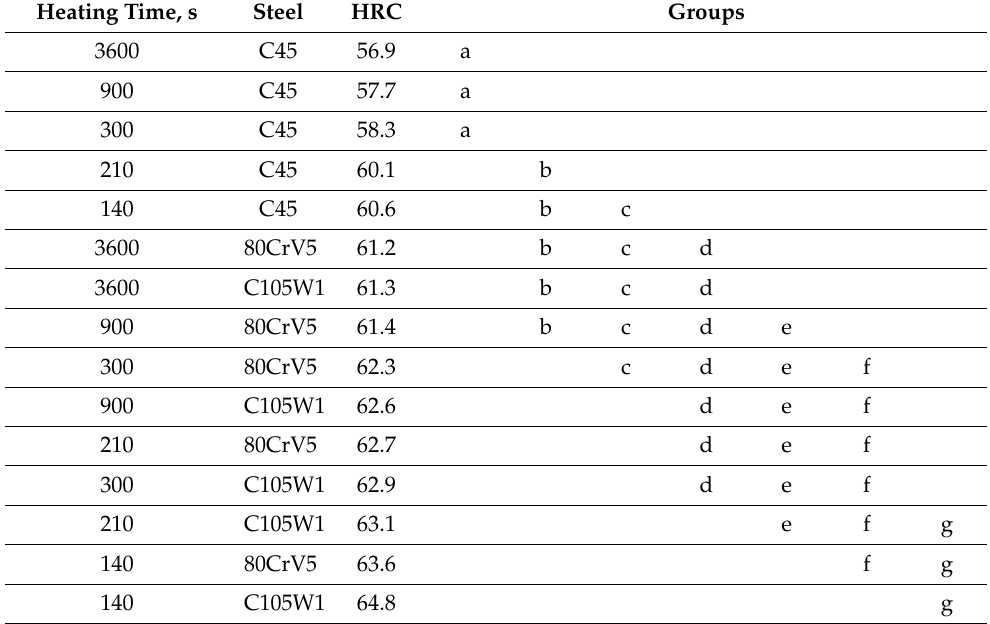
Figure 8. Graphical results of the ANOVA test for the significance of the effect of the heating time on the hardness, the points represent mean values, vertical bars show the 95% confidence intervals. Table 4. Tukey’s test results.